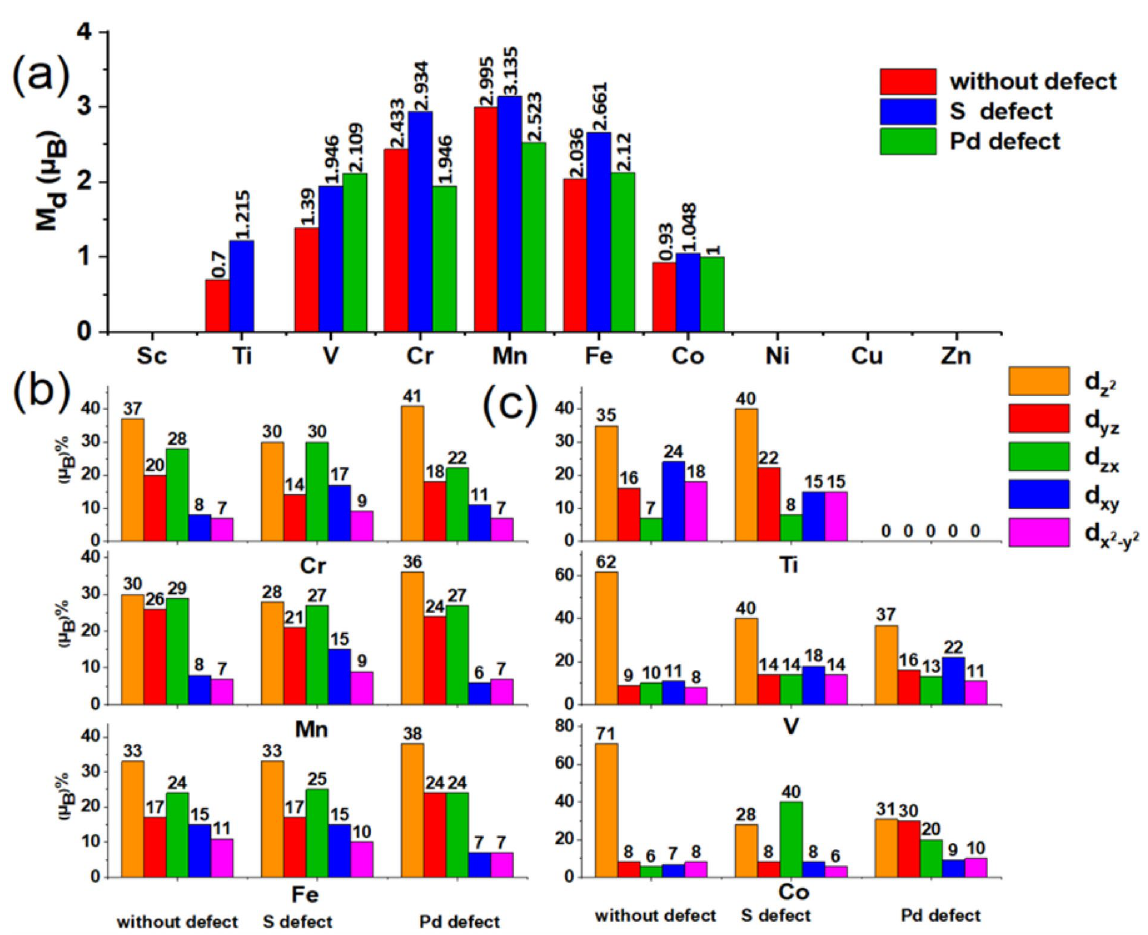
Figure 2. ( a ) Magnetic moment arising from doping of Pd 2 S 4 structure with 3d transition metals with and without S and Pd vacancies. ( b ) Percentage of spin separation for five 3d orbitals of the first group (high magnetization) with and without vacancies. ( c ) Percentage of spin separation for five 3d orbitals of the second group (medium magnetization) with and without